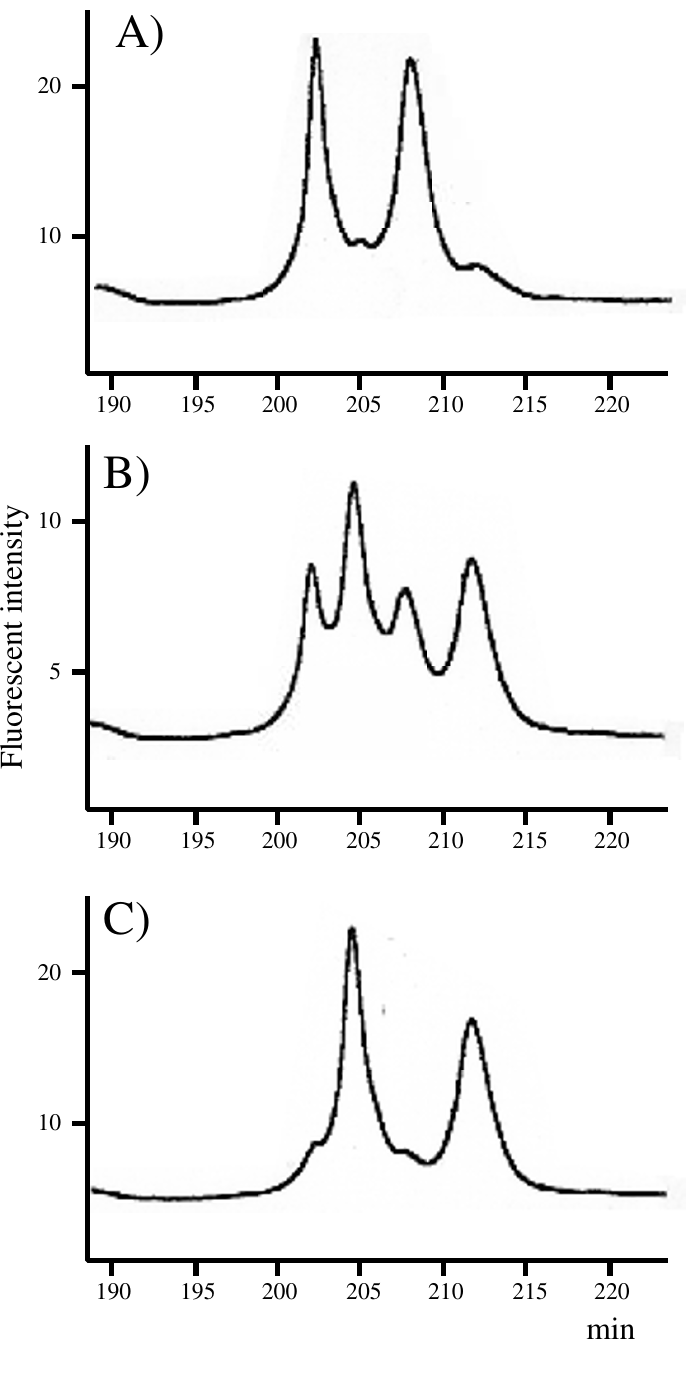
Figure 2 Electrophoretic profile on non-denaturing polyacrylamide gel of adapter-labeled 322-bp DNA fragments obtained with exon 21 primer set of the IHRP gene. A) homo-type of main allele, B) hetero-type of main and minor alleles, C) homo-type of minor